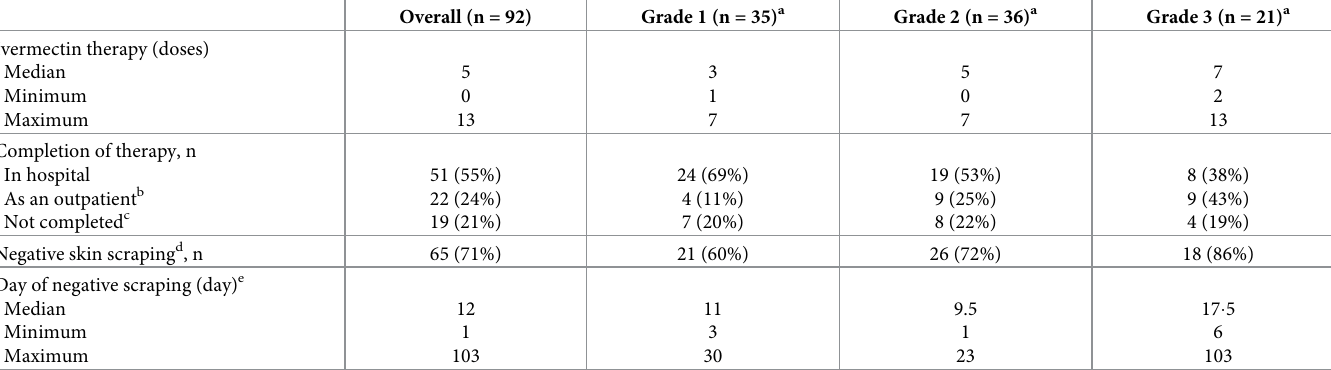
Table 5. Treatment characteristics for crusted